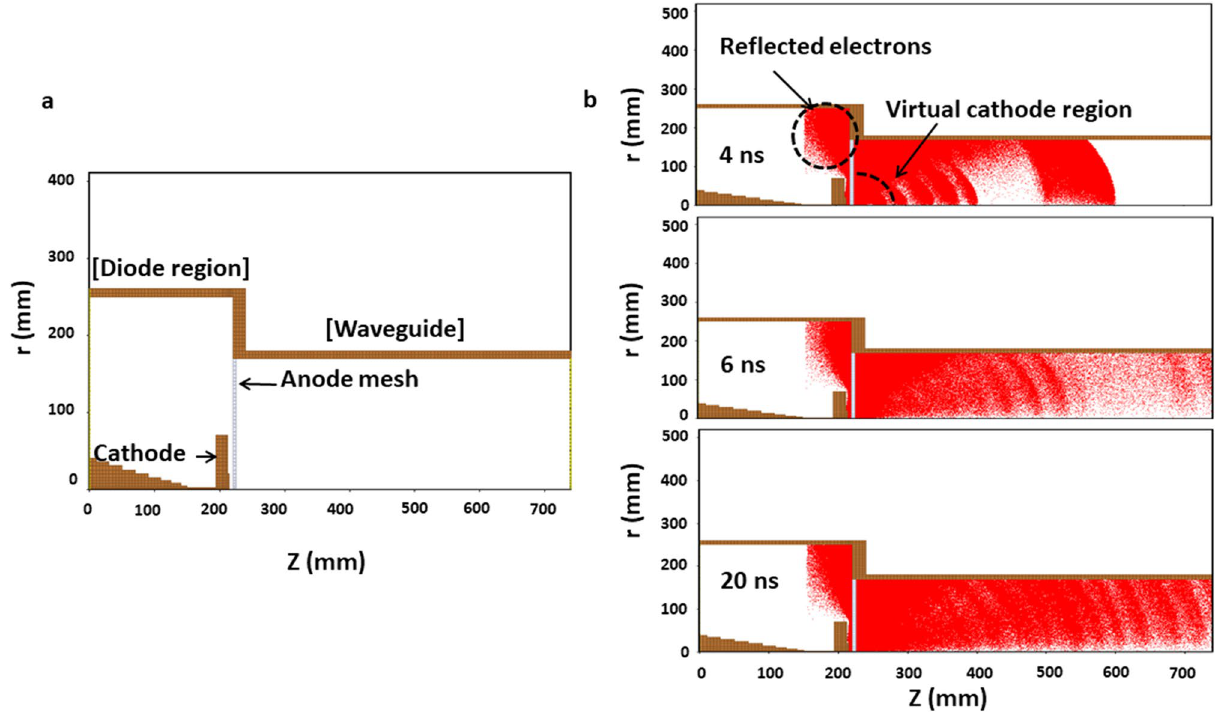
Figure 3. Results of the 3D-PIC simulations: Behavior of electrons inside the diode and formation of the virtual cathode during the simulation time. ( a ) Diode design of the axial-type vircator used in silico (Radius versus electron momentum). ( b ) Phase-space plot for the incremental behavior of electrons inside the diode region at 4, 6, and 20